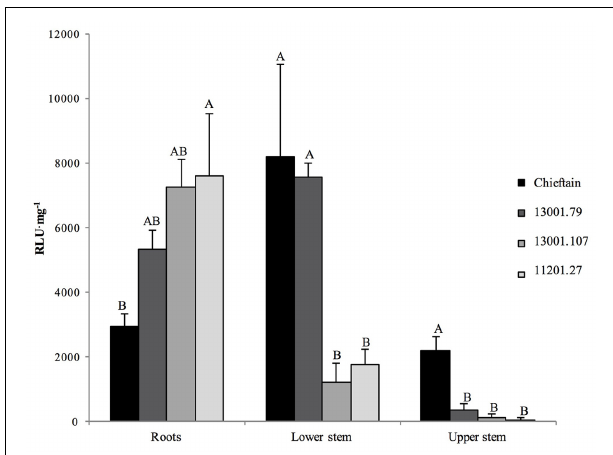
FIGURE 2 | Bioluminescence quantification in roots and stems sections of potato plants 6 days after soil inoculation with R. solanacearum strain UY031 Pps-lux. Light emission is presented as relative luminescence units per milligram of plant fresh tissue (RLU · mg − 1 ). Each column represents the mean luminescence ( n = 6) detected in roots and stems sections of the susceptible potato cultivar S.tuberosum cv. Chieftain and interspecific potato breeding lines with different levels of bacterial wilt resistance including susceptible (13001.79) and tolerant (13001.107 and 11201.27) clones. Columns with the same letter within each sample type (roots, lower stem, upper stem) are not significantly different according the Tukey’s multiple comparison test ( P = 0.05). Vertical bars represent standard errors of the means.